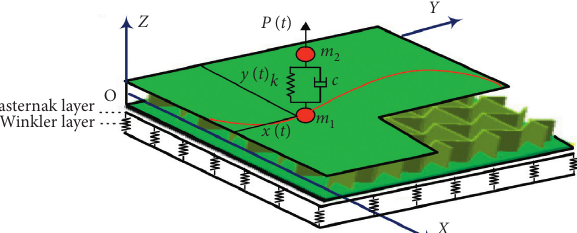
Figure 1: Model of the sandwich composite plate with negative Poisson’s ratio in auxetic honeycomb core layer subjected to moving oscillator load on EF.